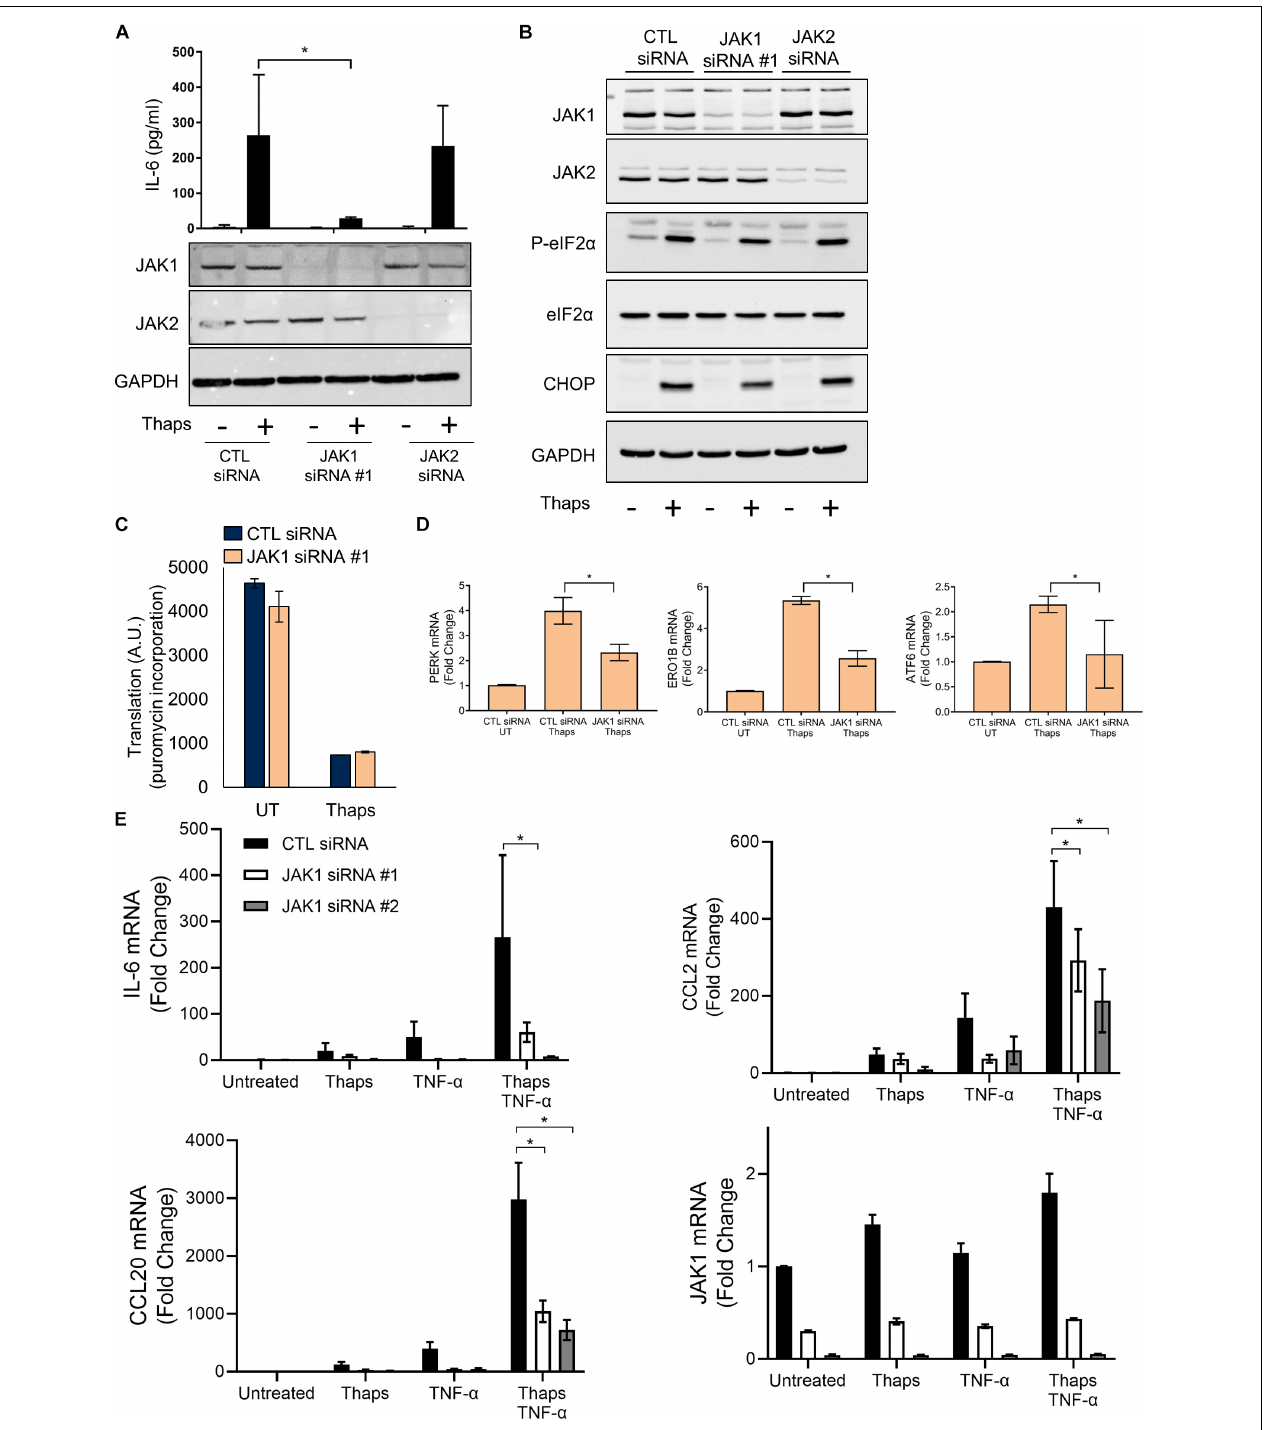
FIGURE 1 | JAK1 is required to drive ER stress-induced IL-6 expression and does not affect canonical PERK signaling. (A) Primary astrocytes were transfected with control (CTL), JAK1, or JAK2 siRNA for 48 h and then treated with thapsigargin (thaps) (1 µ M) for 24 h and analyzed by immunoblot and ELISA. (B) Astrocytes were transfected as in (A) followed by thaps (1 µ M) treatment for 4 h and analyzed by immunoblot. (C) Astrocytes were transfected with CTL or JAK1 siRNA and treated with thaps (1 µ M) for 90 min. In the last 5 min of treatment, puromycin (5 µ g/ml) was added to cultures. Cell lysates were analyzed by dot blot using anti-puromycin antibody and quantified. UT = Untreated. (D) Astrocytes were transfected as in (A) , treated with thaps (1 µ M) for 4 h then analyzed by RT-qPCR. UT = Untreated. (E) Primary astrocytes were transfected with one of two distinct JAK1 siRNAs and treated with thaps (1 µ M), TNF- α (5 ng/ml), or both thaps and TNF- α for 4 h and analyzed by RT-qPCR. N = 3. ∗ p ≤ 0.05. Data are represented as means ± standard deviation.